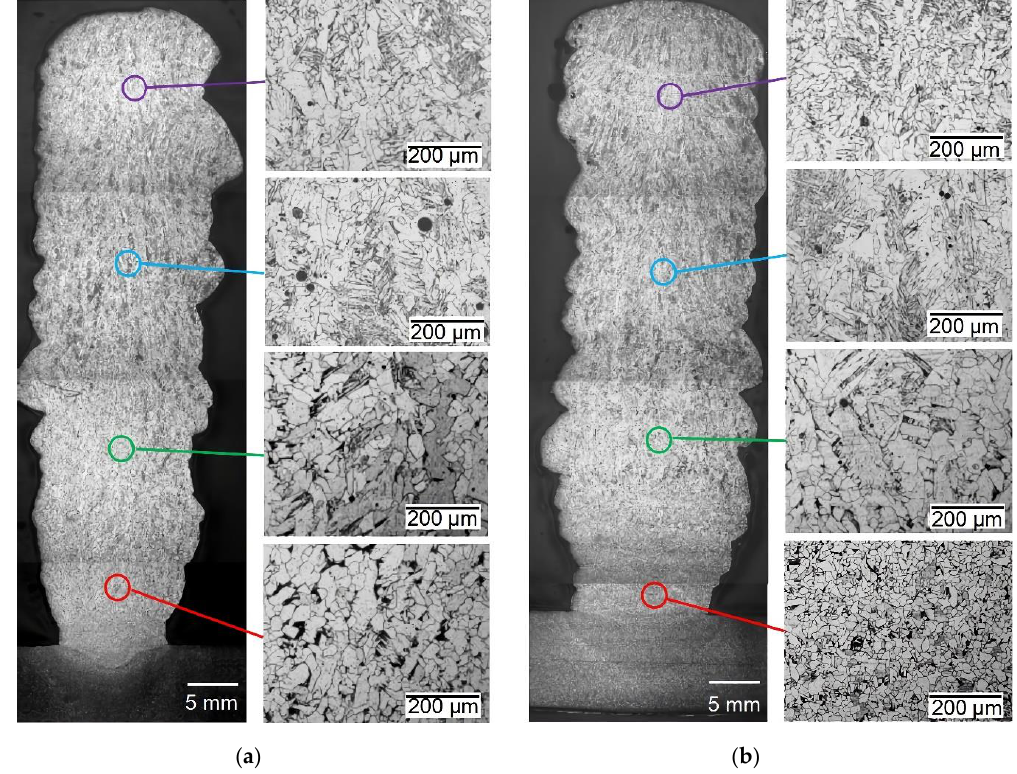
Figure 9. The optical microstructure of the multilayer weld deposition: ( a ) G3Si1 standard wire; ( b ) G3Si1 wire with Ni-LaF 3 coating of 6 μm in thickness.